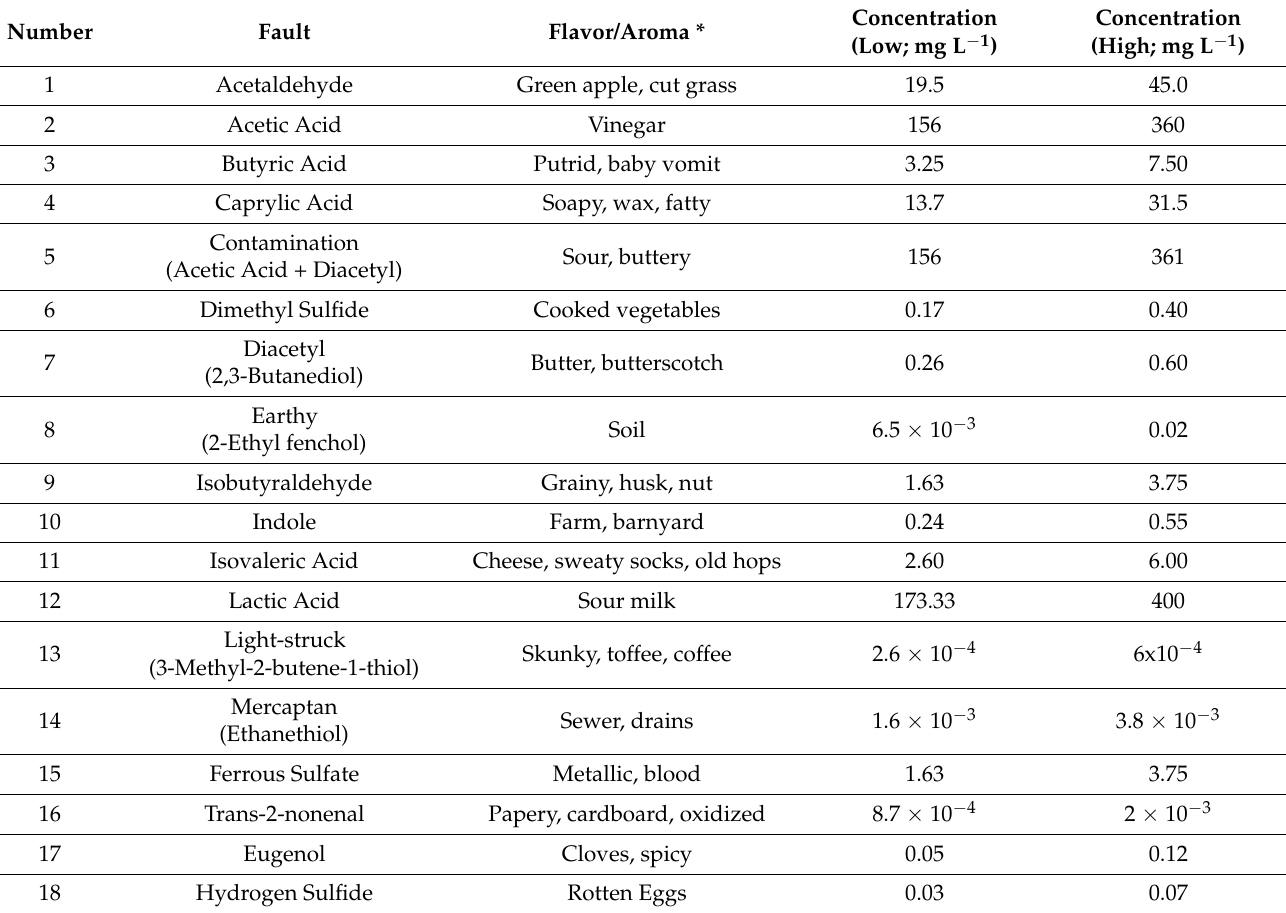
Table 2. Compounds used as off-flavors/aromas (faults) to spike beer samples and the concentrations used for training purposes according to human detection